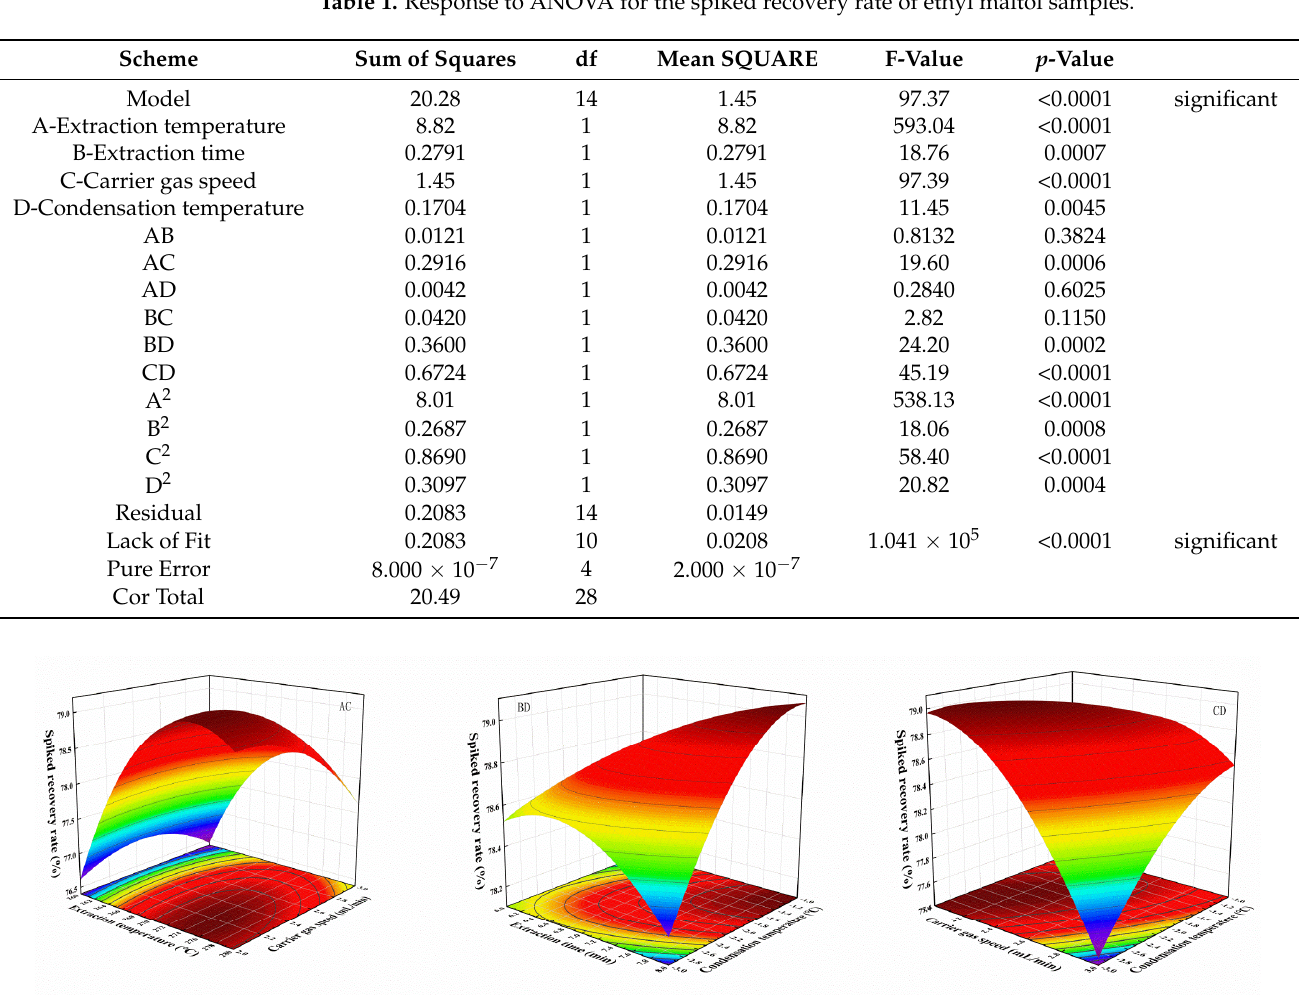
Figure 2. Effect of factors AC, BD, and CD interaction response surface.